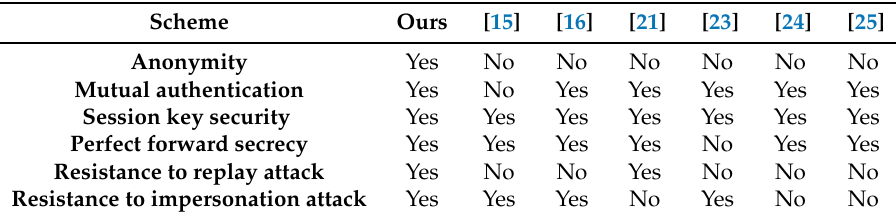
Table 4. The comparison of security